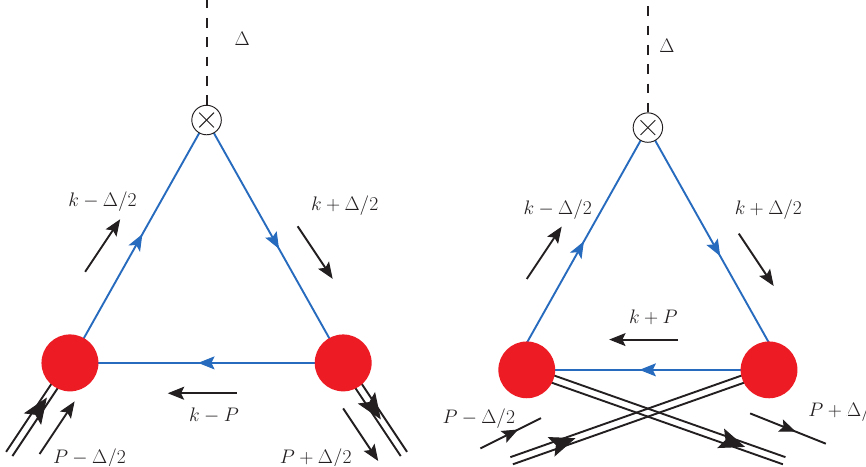
Figure 7. Triangle diagrams used in early computations of meson EFF, PDFs and